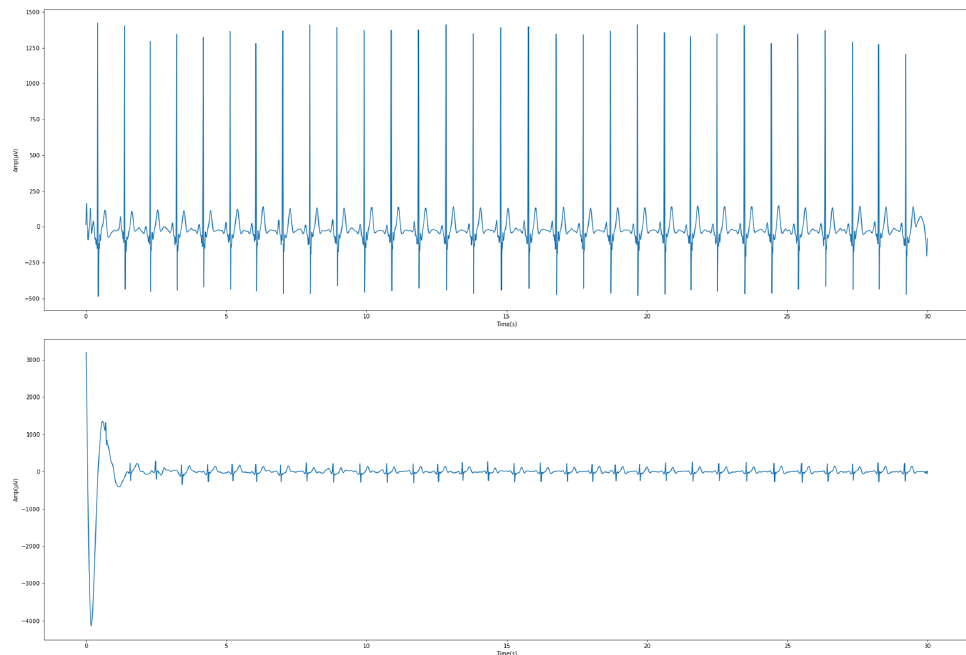
Figure 4. Differences in the R peaks of the ECGs for different subjects.